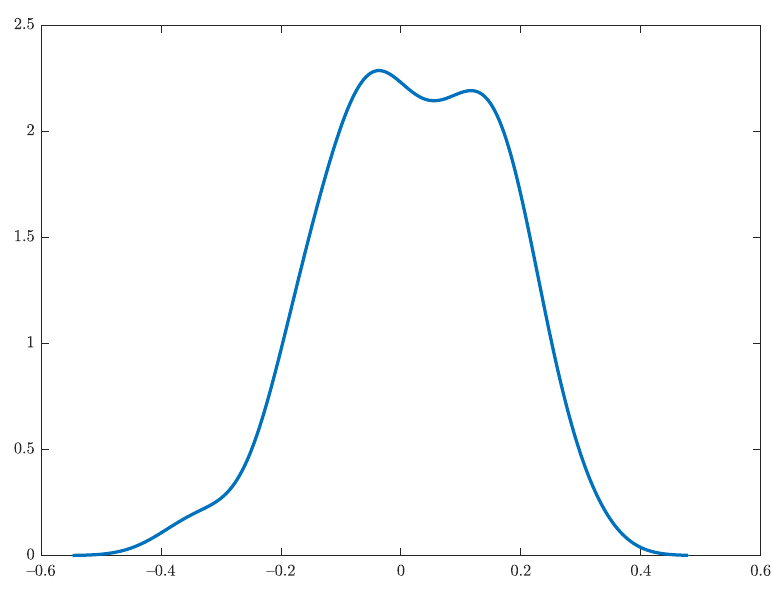
Figure 2. Empirical density function of the historical correlation between S&P 500 and Euro/US- Dollar exchange rate, computed with the MATLAB function ksdensity